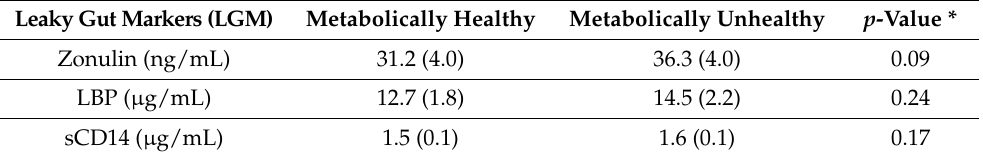
Table 6. LGM levels of metabolically healthy ( n = 14) and metabolically unhealthy ( n = 14) subjects after an acetylsalicylic acid challenge.